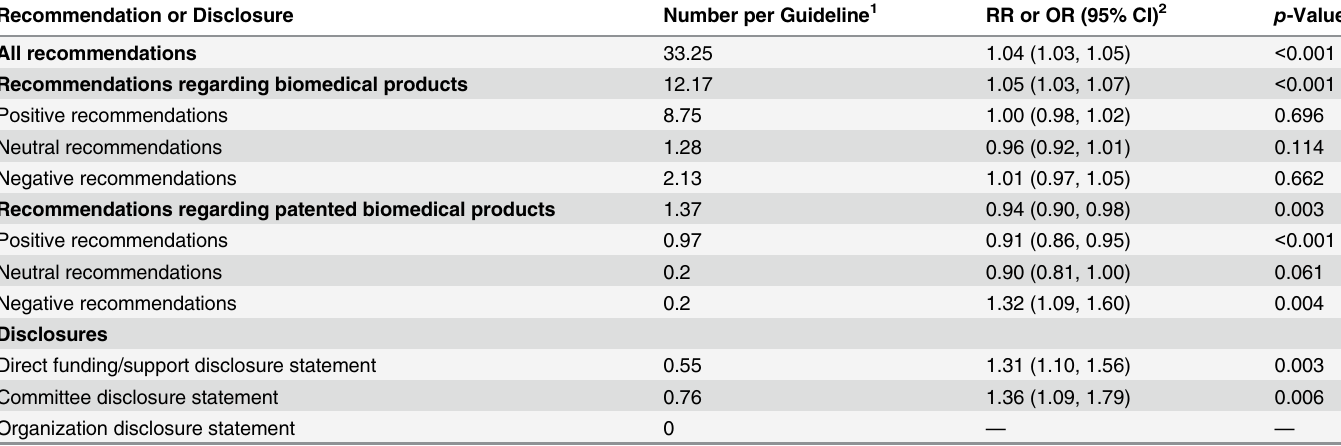
Table 5. Clinical practice guideline recommendations and disclosures according to the number of procedures in an organization ’ s conflict of interest